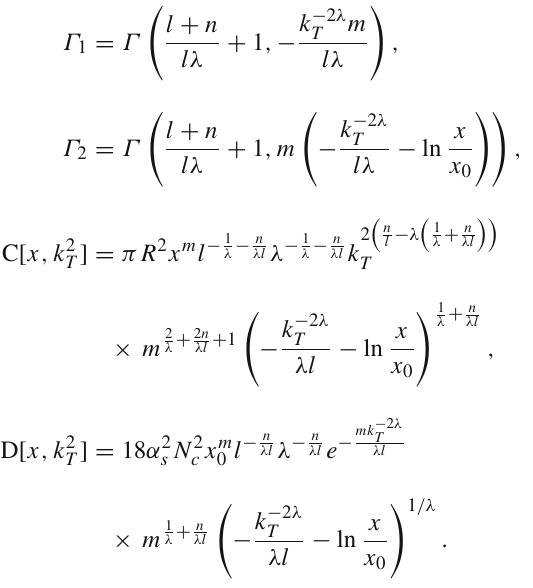
) and xg ( x , Q 2 ) shows figure. Our evolution for both f ( x , k 2 T a similar growth as modified BK as well as datasets respec- ) tively for all x . It is also observed that the growth of f ( x , k 2 T (or xg ( x , Q 2 ) ) is almost linear for the entire kinematic range (or Q 2 ). This is expected since the net shadowing term of k 2 T dependence, which suppresses the contri- in (16) has 1 / k 2 T . bution from the shadowing term at large k 2 T values viz. 5 GeV 2 , 50 GeV 2 and Figs. 6 and 7 for two k 2 T two Q 2 values viz. 35 GeV 2 , 100 GeV 2 . The input is taken